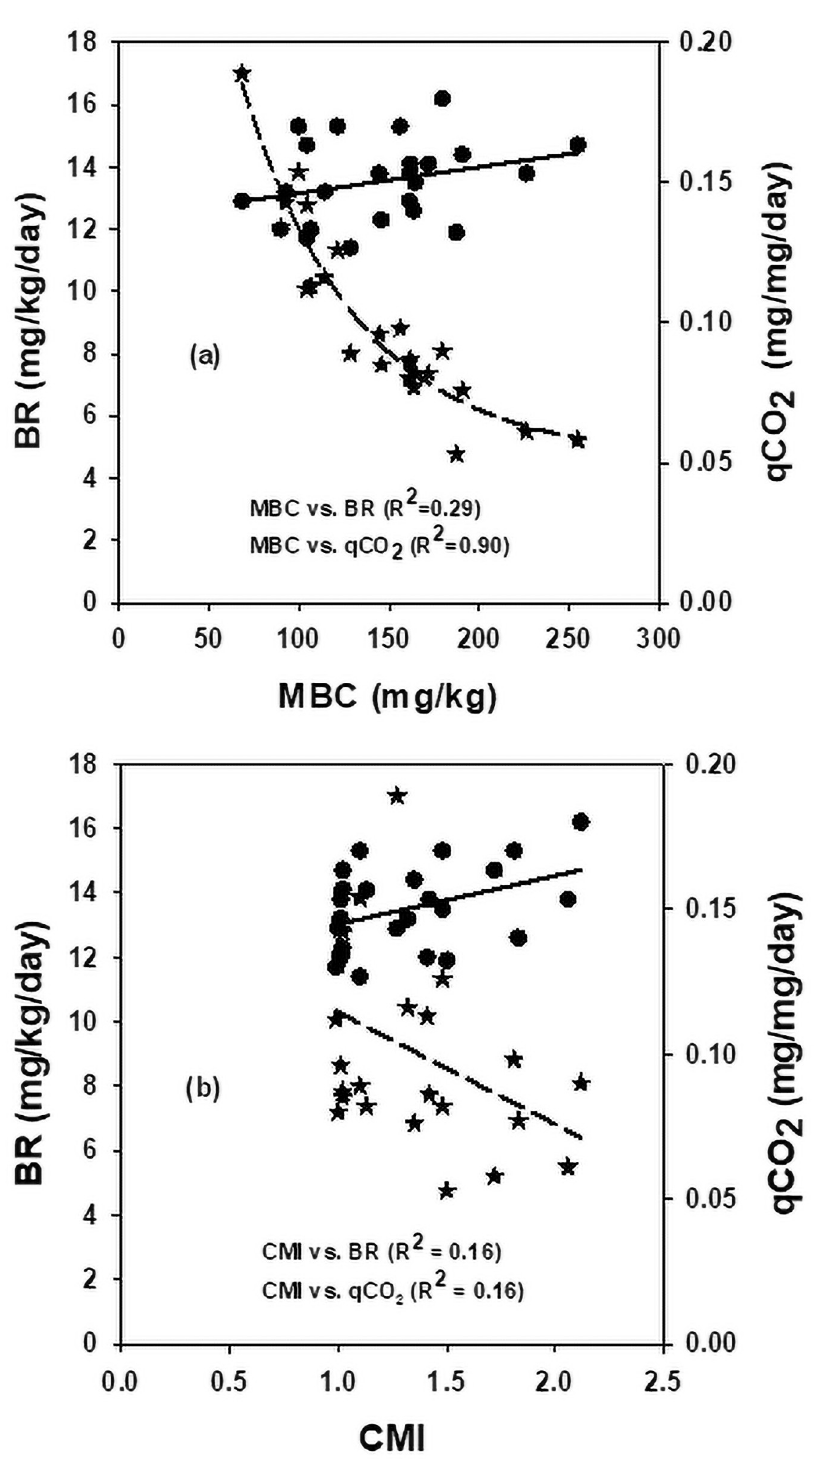
Fig 3. Relationship of (a) microbial biomass carbon with basal respiration and specific maintenance rates, and (b) carbon management index with basal respiration and specific maintenance rates, averaged across data.